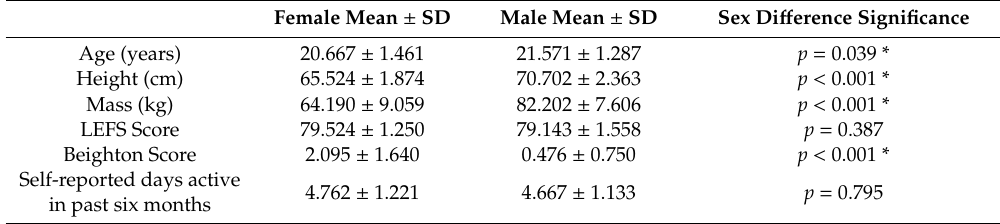
Table 1. Analysis of demographic statistics.